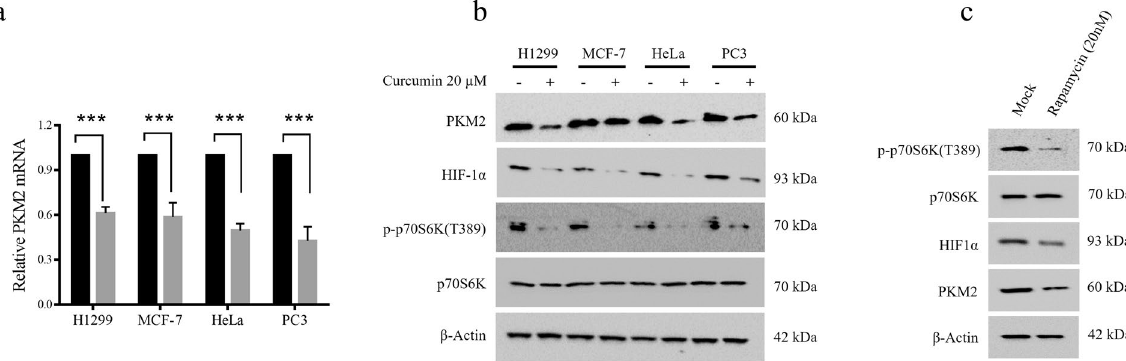
Figure 2. PKM2 expression is inhibited by curcumin through mTOR/HIF1 α axis. ( a ) Substantial reduction in PKM2 mRNA in H1299, MCF-7, HeLa and PC3 cells treated with 20 μ M for 24 hours. ( b ) Immunoblot of H1299, MCF-7, HeLa and PC3 cells showing coincided reduction in PKM2, HIF1 α and phosphorylated- p70S6K (T389), upon curcumin treatment. ( c ) Treatment with standard mTOR inhibitor-rapamycin also showed similar expression pattern. Results suggested that curcumin inhibited PKM2 expression via inhibition of mTOR and HIF1 α . Error bars in PKM2 mRNA graph represent mean ± SD.